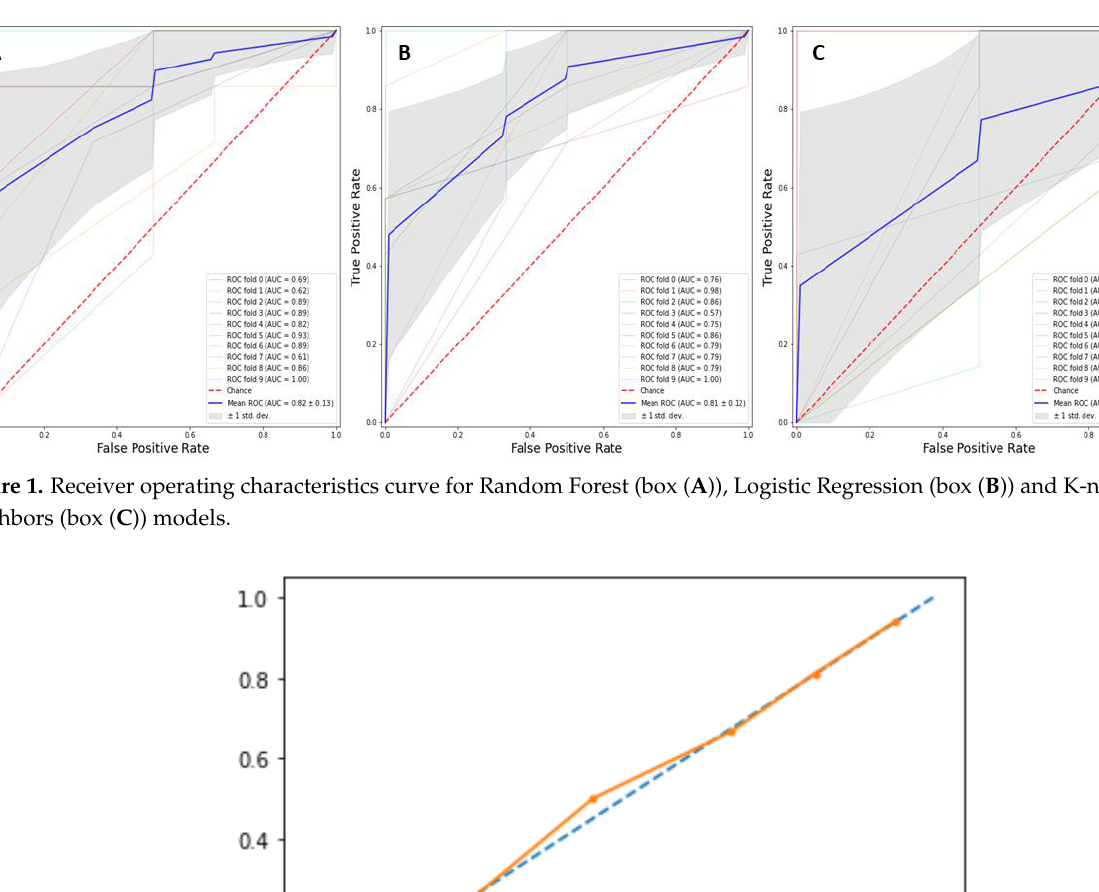
Figure 2. Calibration diagnostics for RFF model. 24-month PFS roughly happened with an observed relative frequency consistent with the forecast value, showing good calibration.